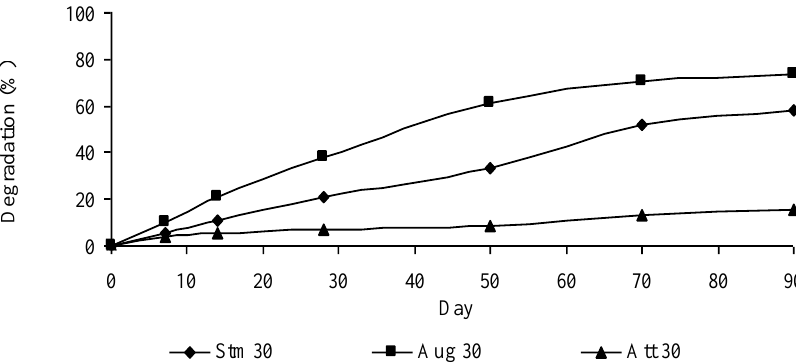
Figure 2. Comparison natural attenuation, biostimulation and bioaugmentation in 30 g oil concentration